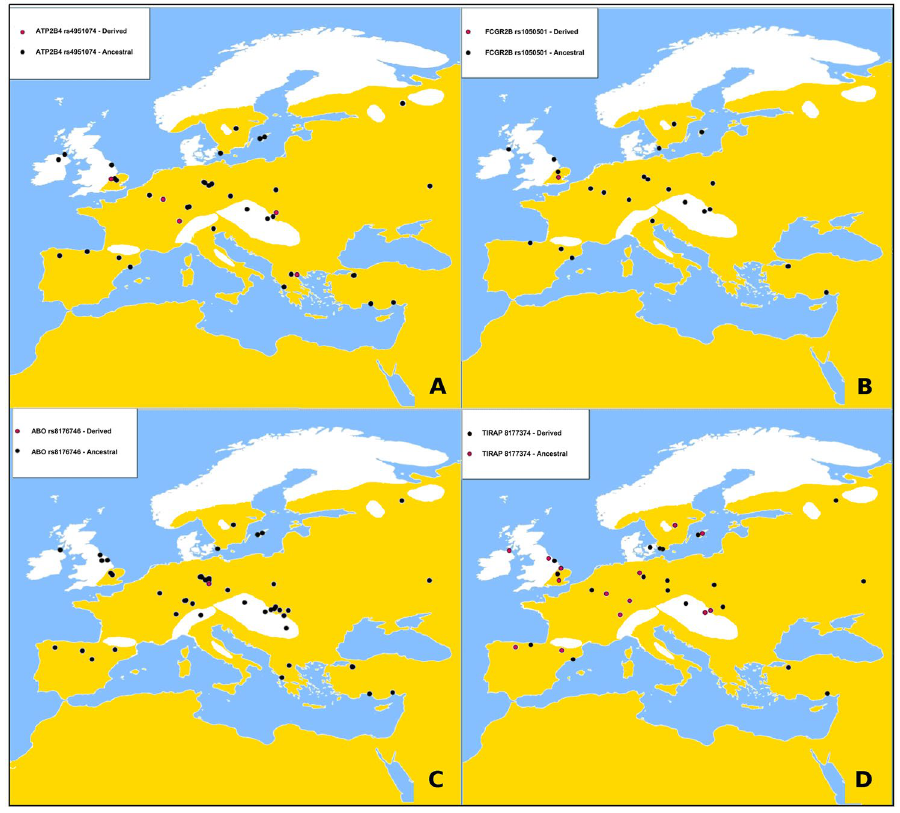
Figure 2. Geographical distribution of the rs8176746, rs4951074, rs1050501 and rs8177374 alleles in ancient European populations. The black circles represent those individuals with ancestral variants and red circles represent those individuals with derived variants presumably associated to malaria resistance. The map depicts the malaria-endemic zone 57 . The maps were made using Worldmap package 1.3.1 of R software 3.2.2 (http:// cran.r-project.org), and modified with Gimp 2.6 (http://www.gimp.org) and Pinta 1.6 (http://pinta-project.